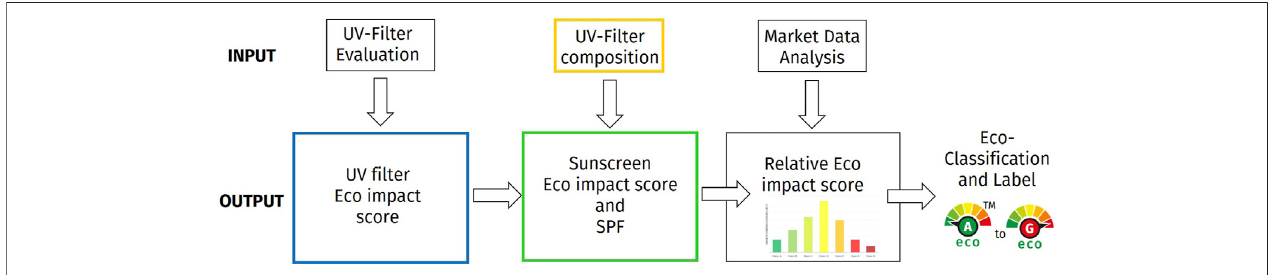
FIGURE 1 | Flow chart for the in-silico formulation evaluation, UV Filter evaluation, Filter composition and supporting market data relevance estimation-leading in combination to Eco classi fi cation and corresponding Ecolabel.